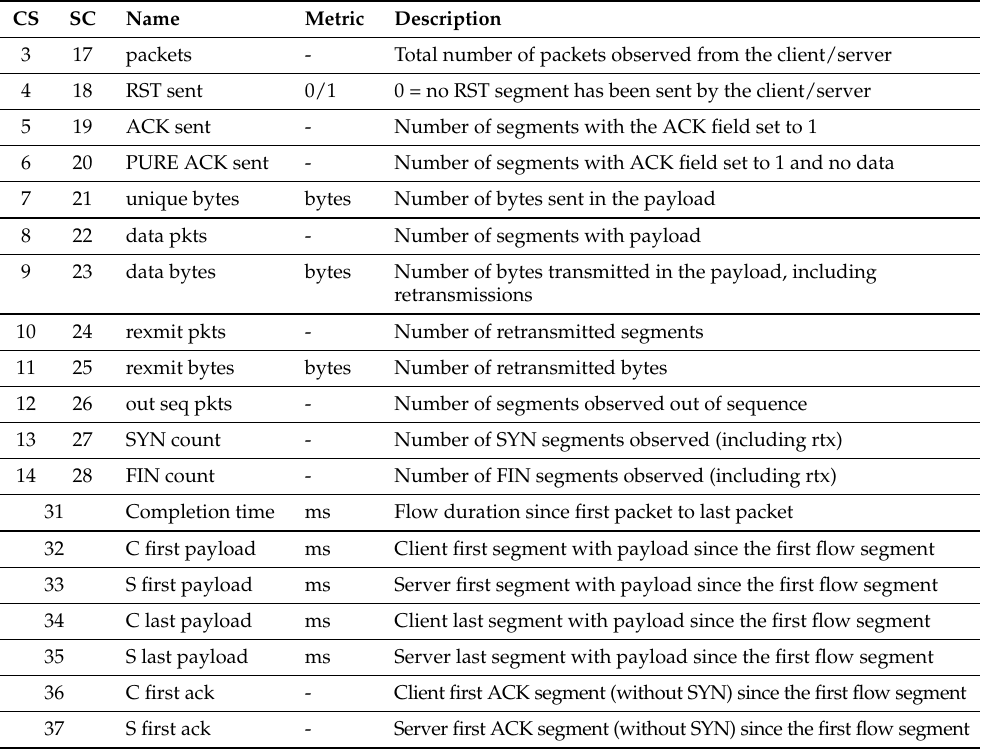
Table 4. Tstat selected features for DoH flooding attack